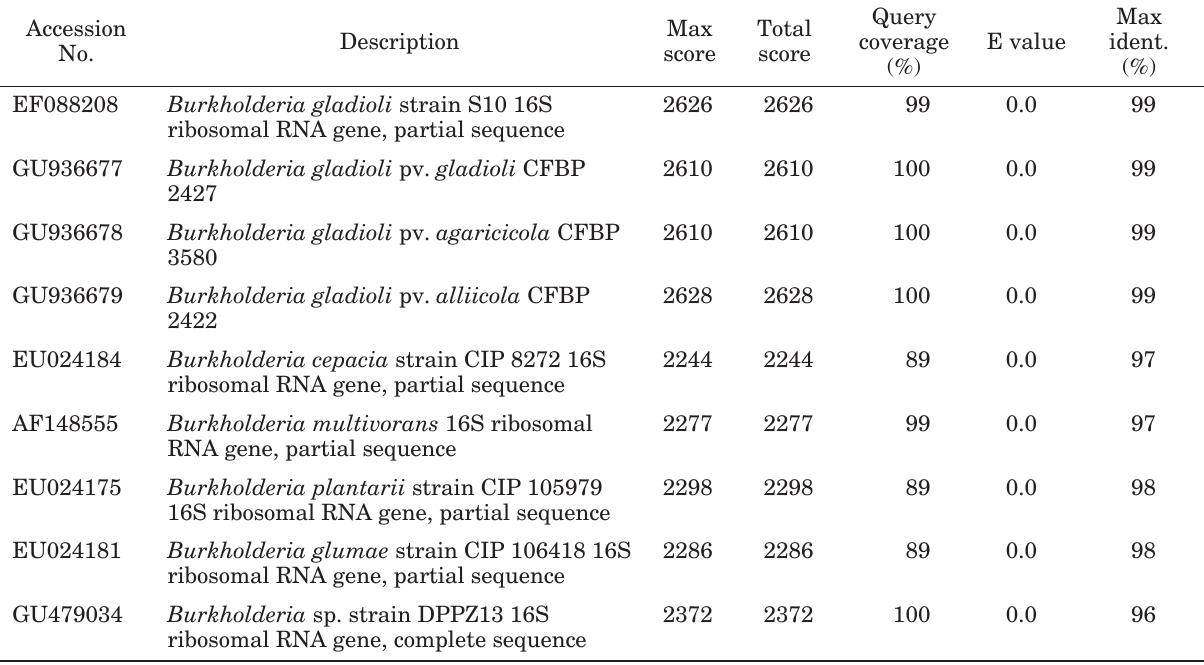
Table 3. Comparison between B. gladioli pv. gladioli (strain DPPZ22, group B) GU479033 and other Burkholderia